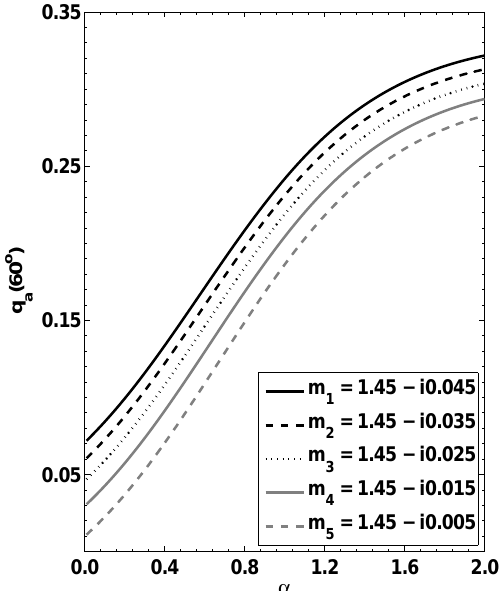
Fig. 10. Calculated q a ( 60 ◦ ) versus α , for five different complex re- fractive indices with the same real part but different imaginary parts based on the Mie scattering theory.